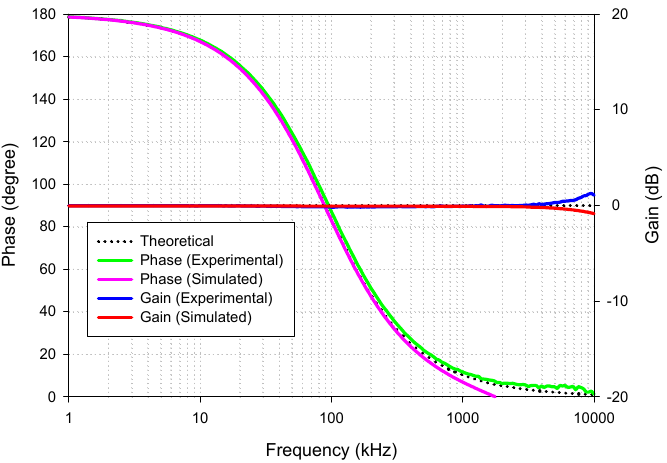
Figure 15. Frequency gain and phase response of AP+. The simulated and experimental AP+ phase response with different I B values (67 μ A, 124.5 μ A, 245 μ A) is shown in Figure 16 where R 1 and R f remained at 1.2 k Ω . The results revealed that the phase of AP+ was electronically controllable, as expected in Table 2. With these values of I B , the theoretical phase angles at f = 90 kHz were 56.62°, 90°, and 126.15°, respectively, while the simulated phase angles from these I B values were 55.86°, 88.95°, and 125.26°, respectively. The percent errors of the simulated phase angles from these I B values were 1.34%, 1.17%, and 0.71%, respectively. The experimental phase angles from these I B values were also 58.54°, 92.28°, and 128.49°, respectively. The percent errors of the experimental phase angles from these I B values were 3.39%, 2.53%, and 1.85%, respectively. Figure 17 shows the measured input and output waveform of AP+ with different I B values (67 μ A, 124.5 μ A, 245 μ A) where the input signal amplitude was 20 mVp ‐ p.